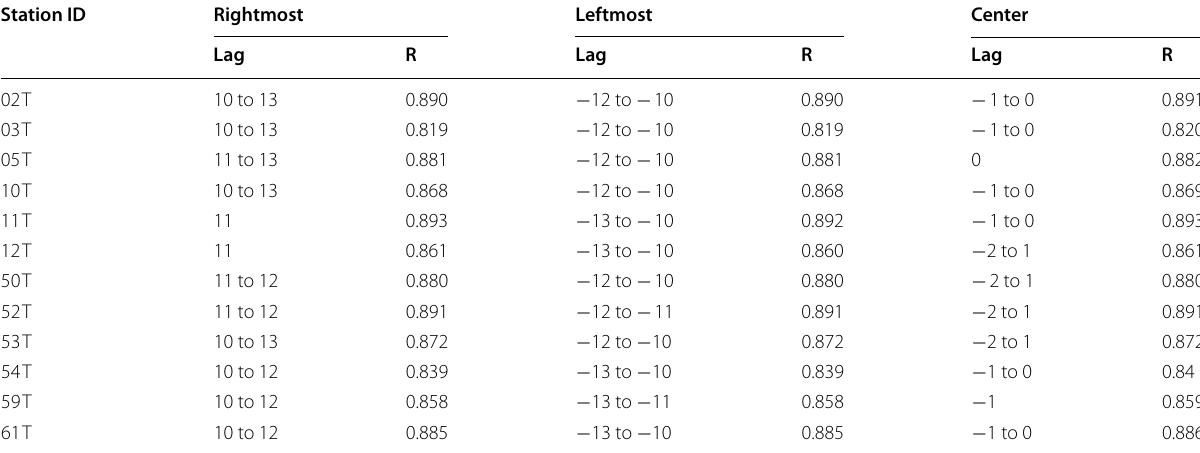
Table 2 Highest correlation and its corresponding lag (h) of all stations Station